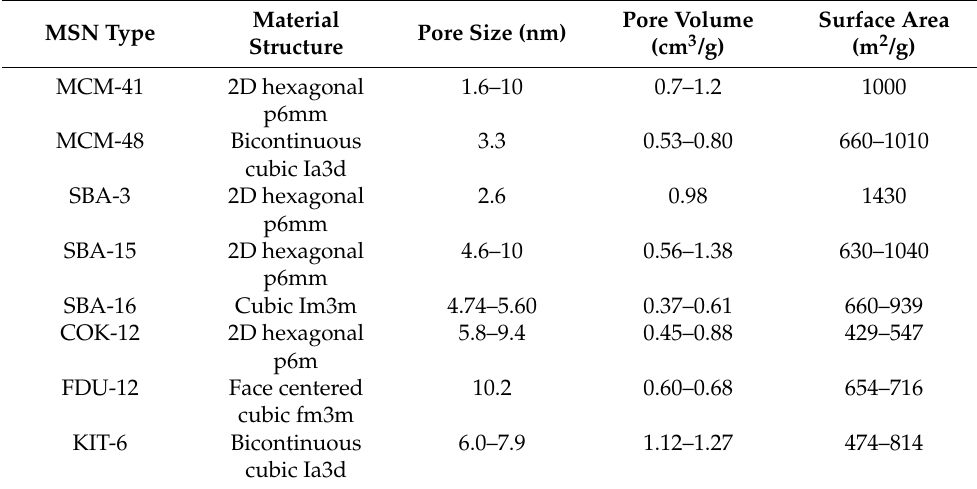
Table 2. Overview of the most studied types of MSN and characteristics of their structure, pore size, volume and surface area. Reprinted with permission from [169]. Copyright 2020